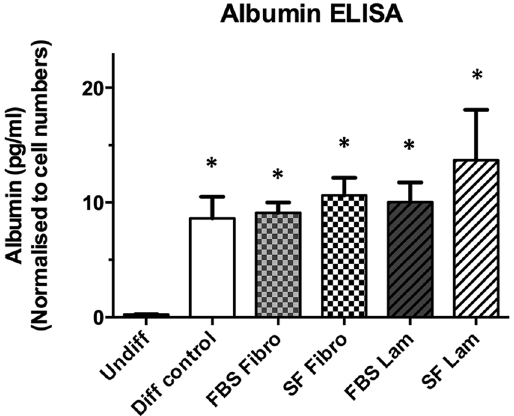
Figure 8. Albumin secretion of undifferentiated AR42J-B13 cells and cells subjected to differentiation-inducing conditions on day 5, measured by ELISA-based assay. Undiff - undifferentiated cells; Diff control - differentiation control, with FBS, on plastic; FBS Fibro - differentiation medium, with FBS, on fibronectin; SF Fibro - differentiation medium, serum-free, on fibronectin; FBS Lam - differentiation medium, with FBS, on laminin; SF Lam - differentiation medium, serum-free, on laminin. The data are expressed as means ± SEM with n = 3 and * p < 0.05 compared with undifferentiated